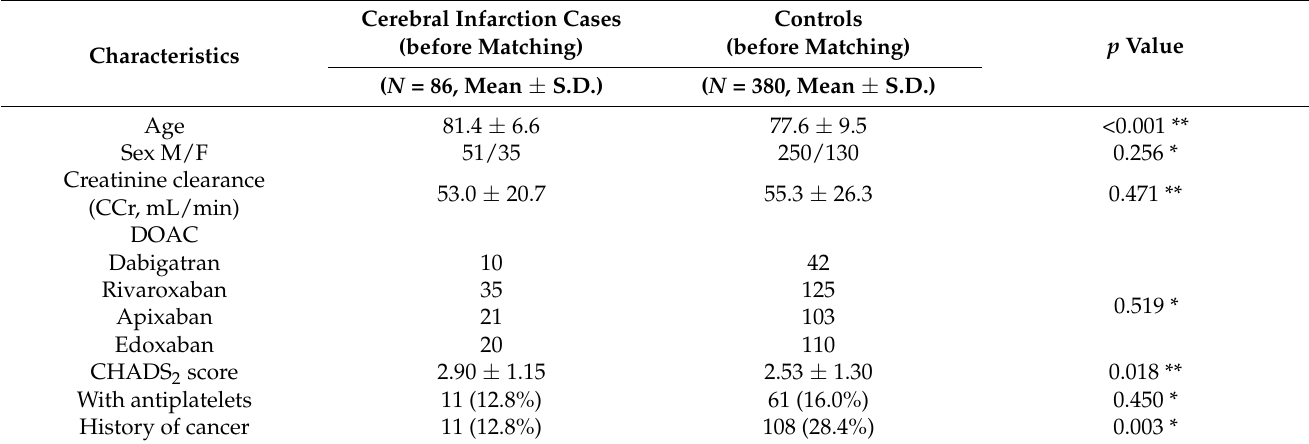
Table 1. Clinical characteristics of the study patients (before